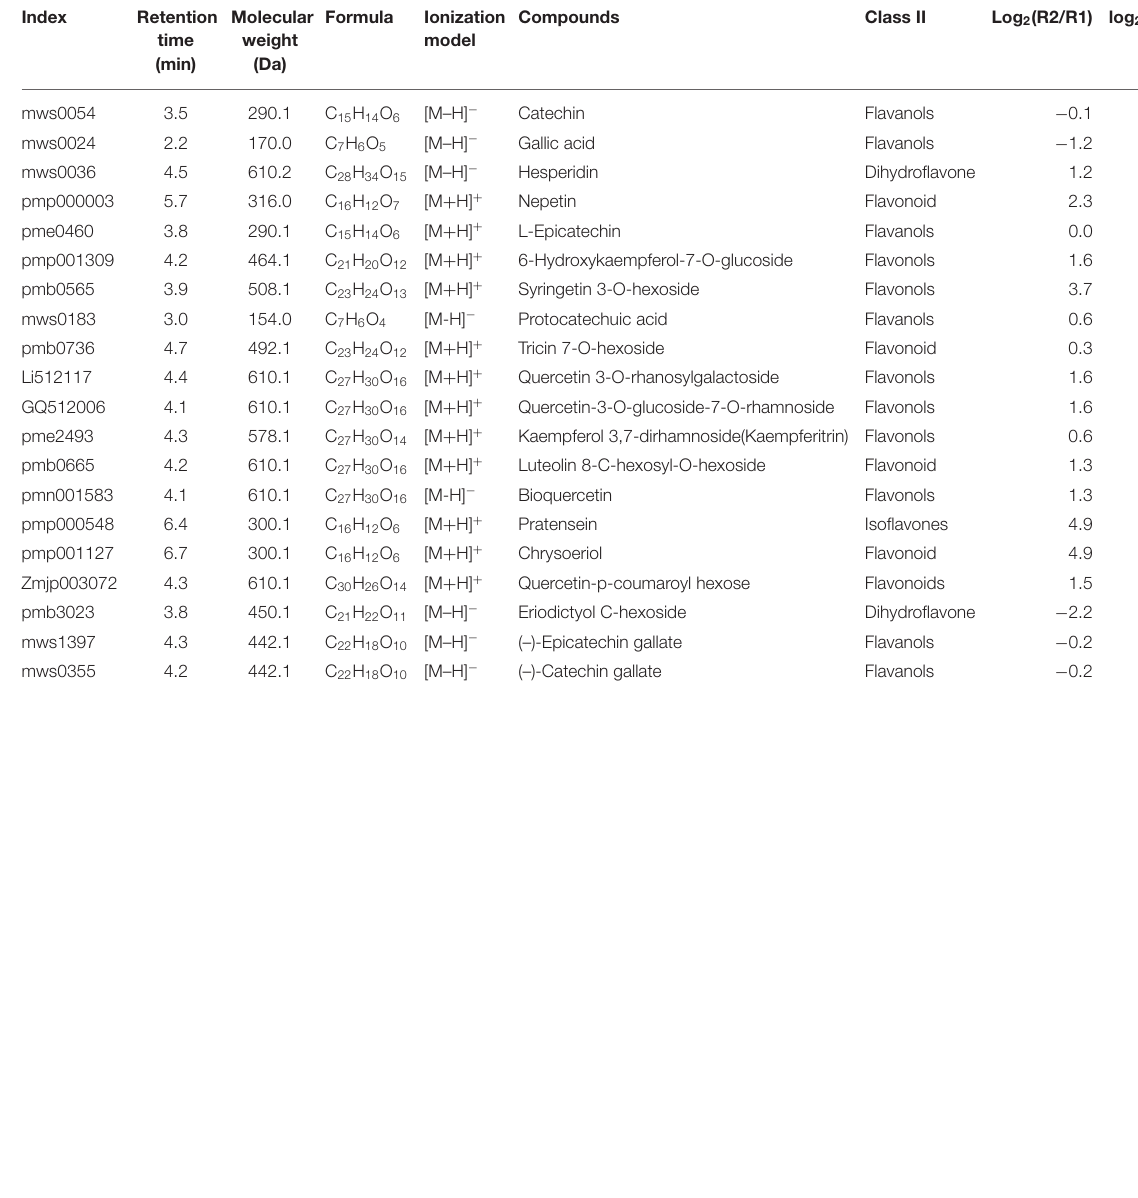
TABLE 1 | Top 20 Flavonoids identified in golden buckwheat